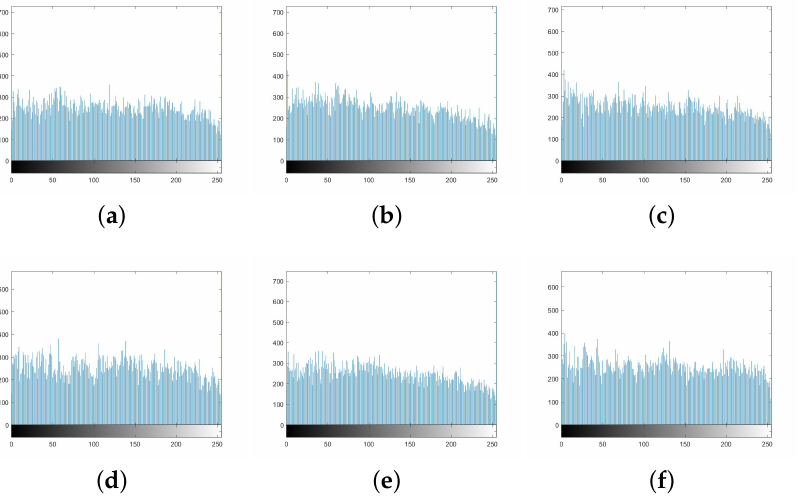
Figure 12. Tonal distribution: histograms of encrypted standard images that are encrypted using the proposed approach: ( a ) aerial; ( b ) lena; ( c ) cameraman; ( d ) jet; ( e ) lake; ( f )